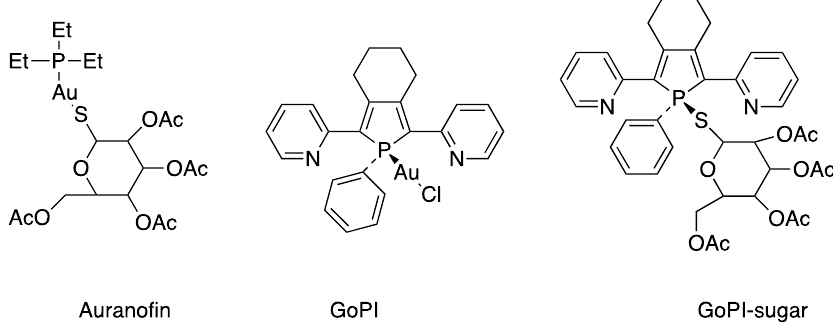
Figure 7. Structures of gold(I) complexes screening against various parasites. Table 2. Biological activity (worm killing activity; motility inhibition; in vitro activity) of a gold complex, GoPI-sugar, in different species [43].